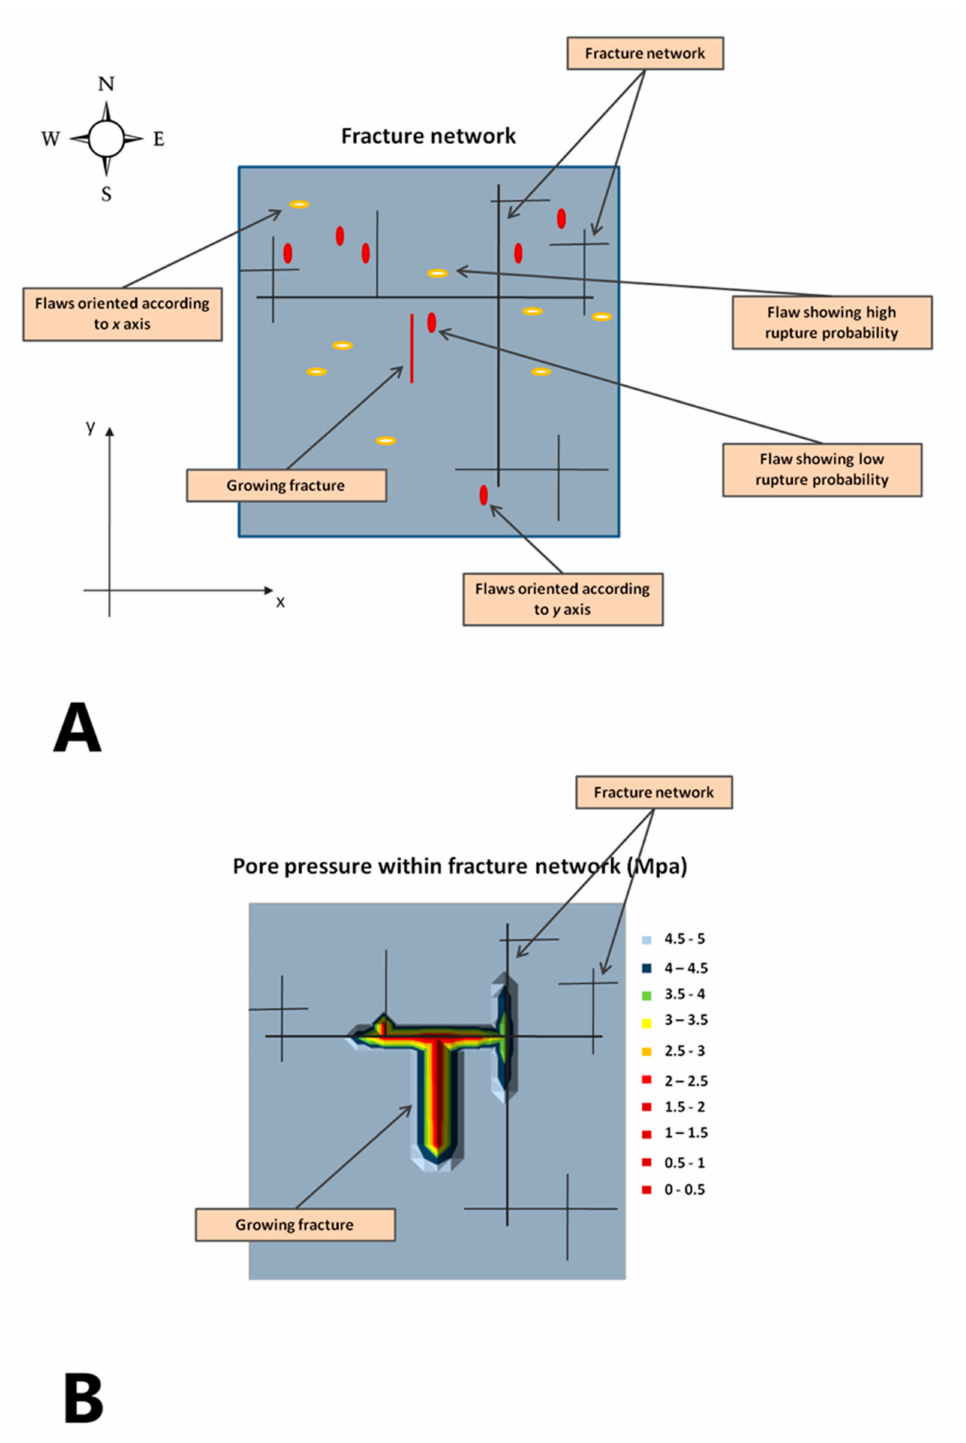
Figure 6. ( A ) Growing fracture near a pre-existing joint network with randomly distributed flaws within host rock. Near the growing fracture (denoted by red line) a stress shadow hinders enucleating of new parallel fractures from flaws, so reducing its probability of rupture. ( B ) When the growing fracture reaches the pre-existing joint network, it causes a pore pressure drop within the nearest fractures, so reducing or erasing or also reverting the stress shadow (e.g., for the EW oriented fracture). As a consequence, the probability of rupture of flaws in the neighbouring rock, is increased and new fractures could be triggered, whose extension is preferentially orthogonal to the here-considered growing